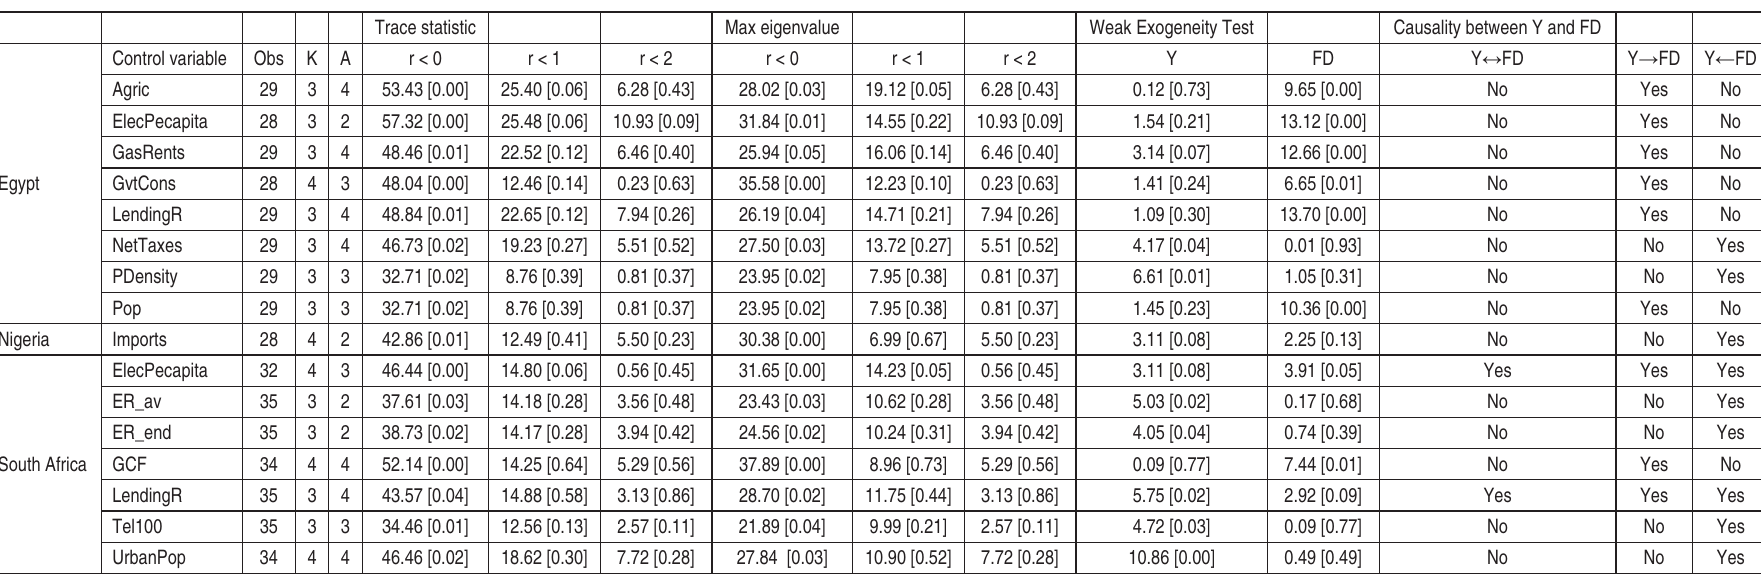
Table 4. Cointegration and weak exogeneity test results for Egypt, Nigeria and South Africa: S-Activity and per capita GDP Trace statistic Max eigenvalue Weak Exogeneity Test Causality between Y and FD